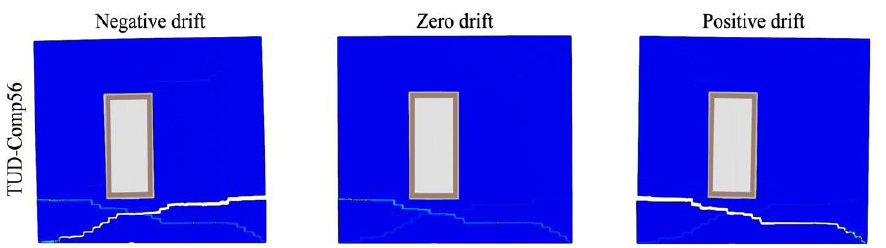
Figure 13. Failure mechanism of the strengthened wall (TUD-Comp56) resulting from the ULS protocol at a displacement of 60 mm (2.3/ − 2.0%).